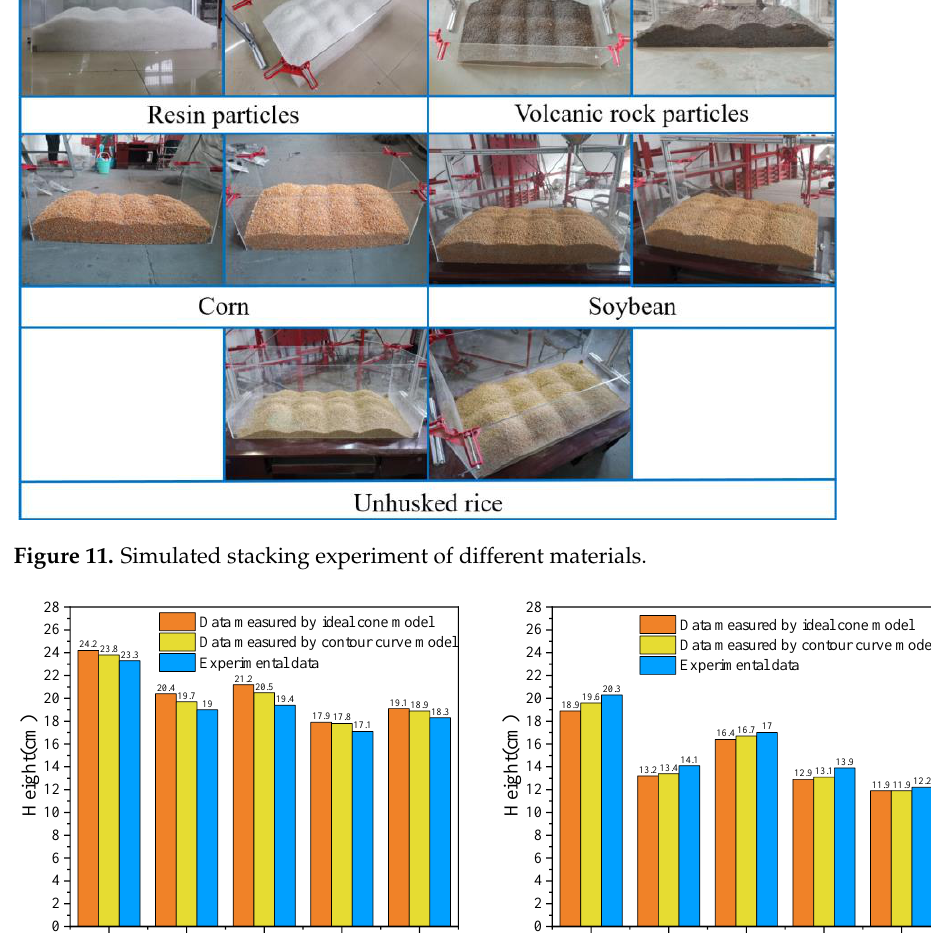
4.1%, and 5.6%, respectively. The relative error of the peak and valley heights of each group was averaged within 5%. Therefore, the heights of the pile peaks and valleys meas- ured experimentally had only small fluctuations in a small range, indicating good stacking flatness.